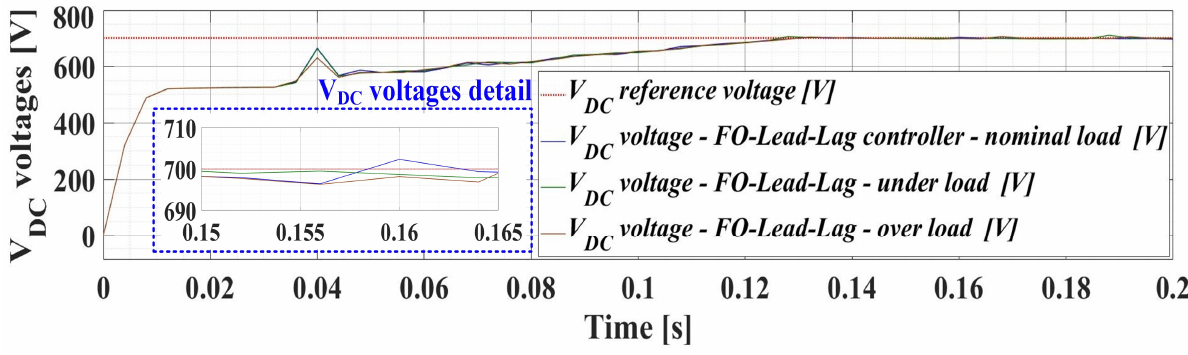
Figure 13. V DC voltages time evolution of the UPQC-APF control system based on PI controller with RL-TD3 agent in case of nonlinear load. In the case of the nominal nonlinear load, Figure 14 compares the V DC voltage evolution in the DC intermediate circuit when using the six types of controllers: PI, PI- GWO, FO-PI, TID, and FO-Lead-Lag controllers, as well as the PI controller with the RL- TD3 agent for correction of command signals. Figure 14. V DC voltages time evolution comparison of the UPQC-APF control system based on presented controllers in case of nominal nonlinear load.